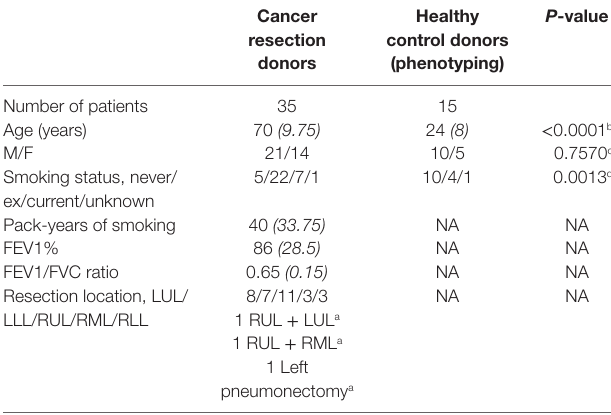
TaBle 1 | Cohort demographics for resection donors and healthy